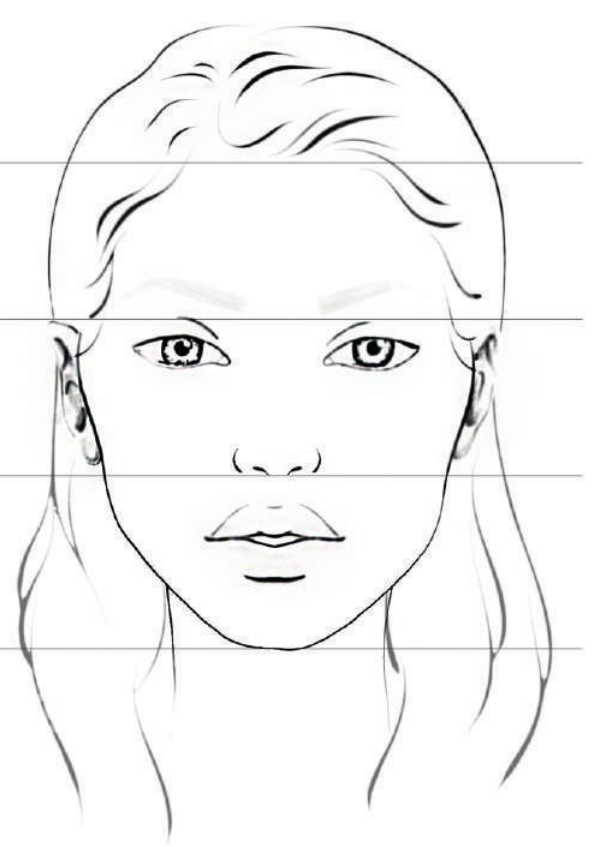
Figure 1. Horizontal thirds of the face according to neoclassical